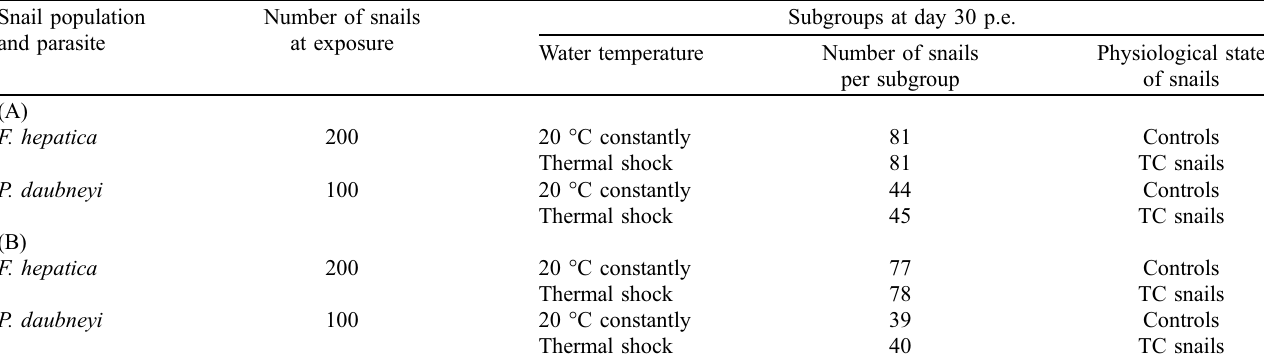
Table 1. Experimental protocol used to study the effect of thermal shock on production of F. hepatica or P. daubneyi cercariae. TC,